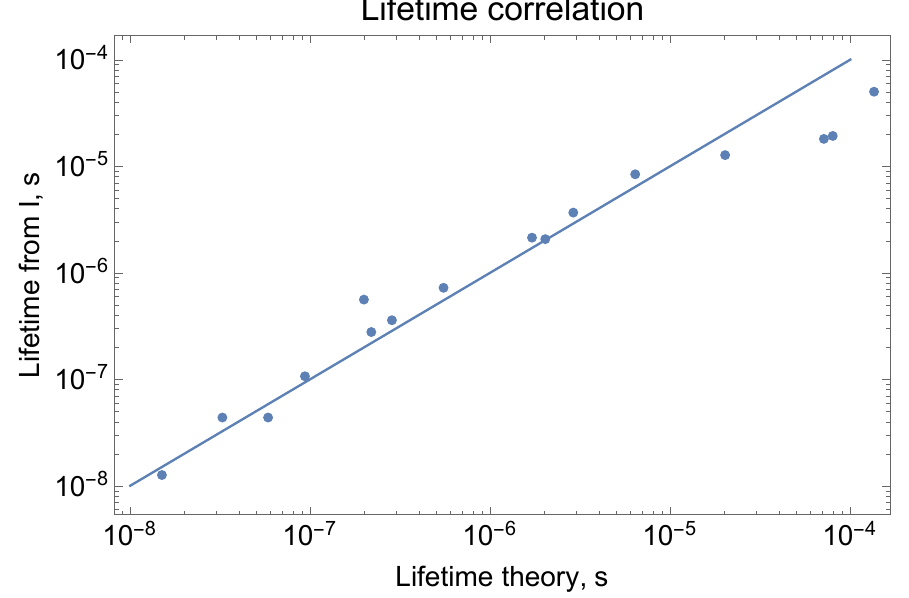
Figure 1. Comparison between theory and experiment for lifetimes of J = 2.5 odd states. Because of strong mixing for the 20,120, 20,310, 20,686 cm − 1 states and 24,463 cm − 1 and 24,873 cm − 1 states, their average lifetimes were plotted with the average energy used in LTE equation. The lifetimes derived from experimental intensities “Lifetimes from I” (the sum of intensities given by NIST for a transitions from a specific level) were scaled with Boltzmann factor Exp[-E/T] and multiplied by a coefficient for best match: T = 4000 cm − 1 and k = 32. The data are also presented in Table